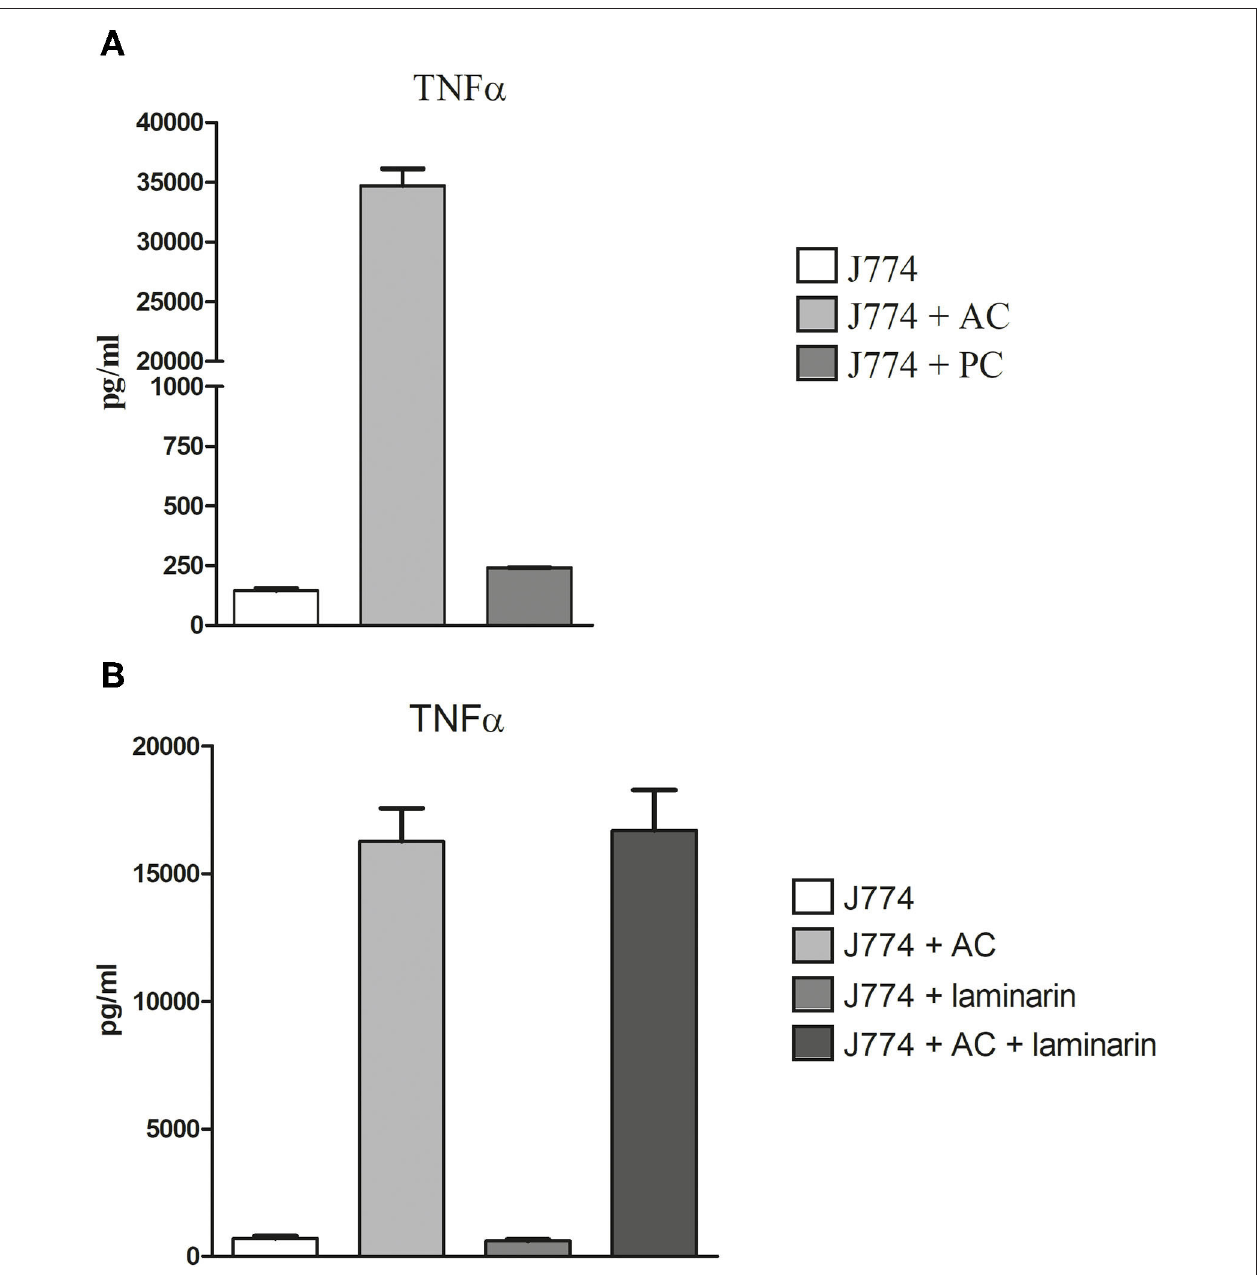
FIGURE 8 | Production of TNF α in AC- and PC-infected J774 macrophages. Macrophages were challenged with 2 AC and 10PC per macrophage (A) . Blocking experiments were performed in the presence or absence of 100 µ g/ml of laminarin (B) . After 6h, supernatants were harvested and the TNF α concentration was determined by ELISA. Each condition was analyzed in triplicate. Standard deviations are